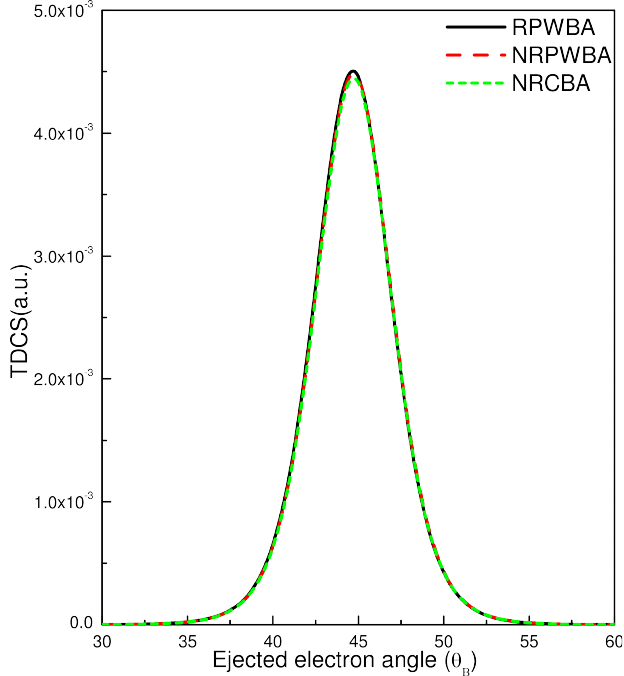
Figure 2. The incident positron kinetic energy is T i = 2700 eV, the ejected electron kinetic energy is T B = 1349.5 eV and geometric parameters are ϕ i = ϕ f = 0 ◦ , ϕ B = 180 ◦ , θ i = 0 ◦ and θ f = 45 ◦ .